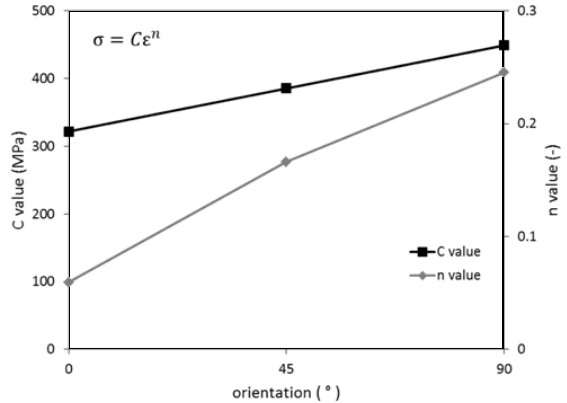
Fig. 13. E ff ect of strain rate on the flow curves of ZEK100 sheet in the 45 ◦ orientation.